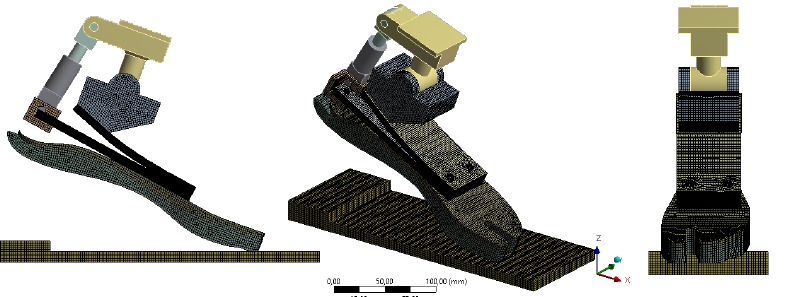
Figure 12. Mesh modeling of the components considered flexible in the analysis. The elastic ele- ments, including the lower blade and the foot shell, were mainly modeled with SOLID186 elements (quadratic behavior). Ankle frame, spring holder and platform were modeled with SOLID185 elements (linear behavior).